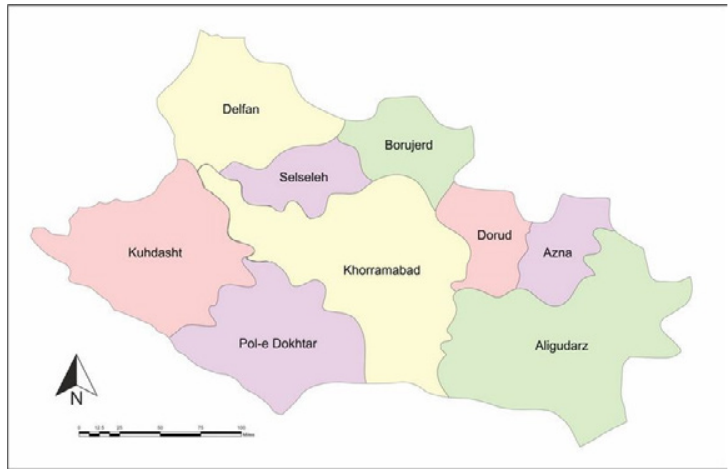
Fig. 4: Location of Lorestan province and Boroujerd city (Borujerd detailed plan, 2017)